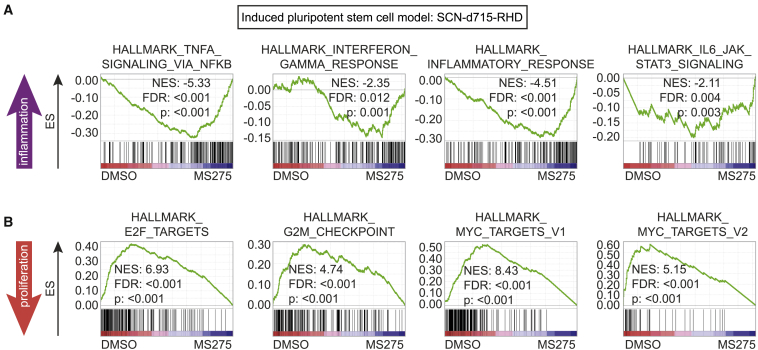
The HDAC Inhibitor MS275 Induces Inflammatory Signatures in SCN iPSC-Derived CD34+CD45+ Cells(A and B) GSEAs comparing CD34+CD45+CSF3R-d715 RUNX1-RHD cells from ELANE mutant SCN cells treated with DMSO or the HDAC inhibitor MS275, derived from two independent experiments (biological replicates), showing (A) induced inflammatory signaling and (B) reduced proliferative signatures in MS275-treated cells.See also Figure S5.